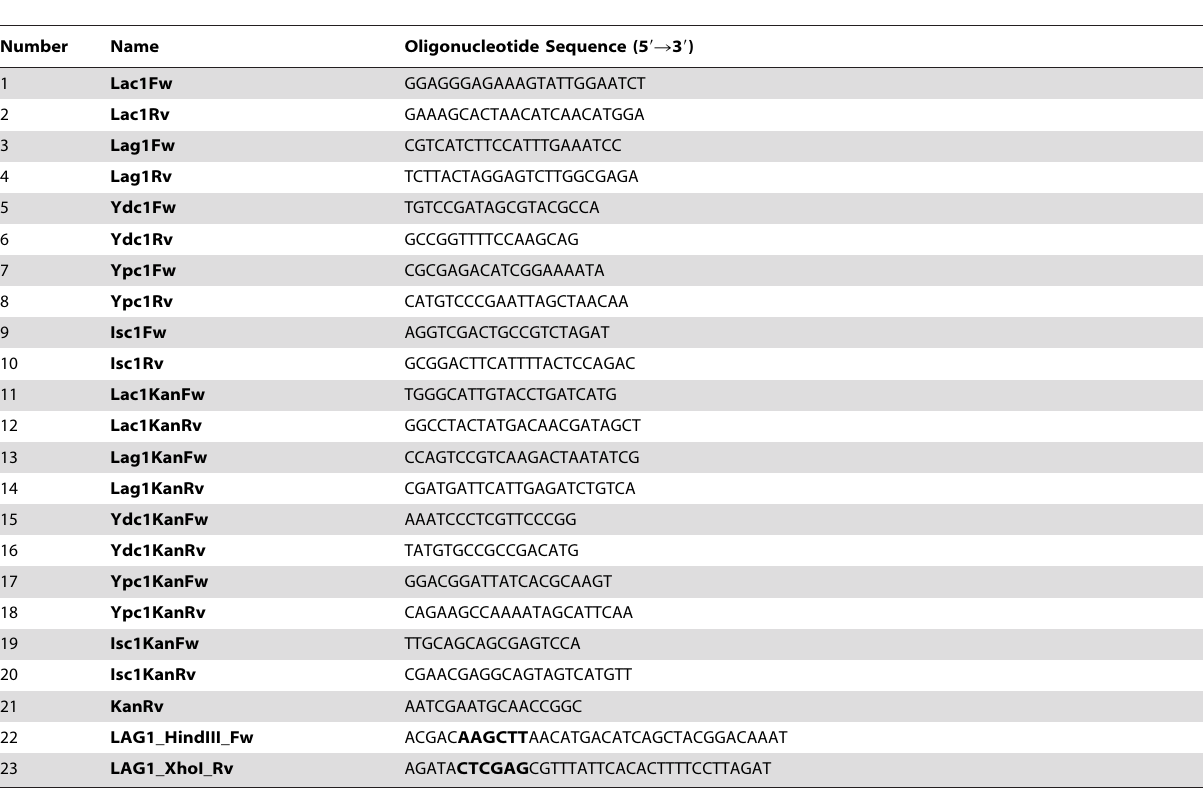
Table 2. List of oligonucleotides used in this